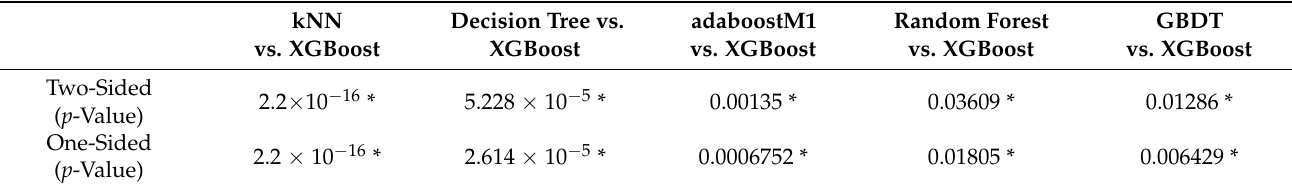
Table 6. Kolmogorov-Smirnov predictive accuracy test (51